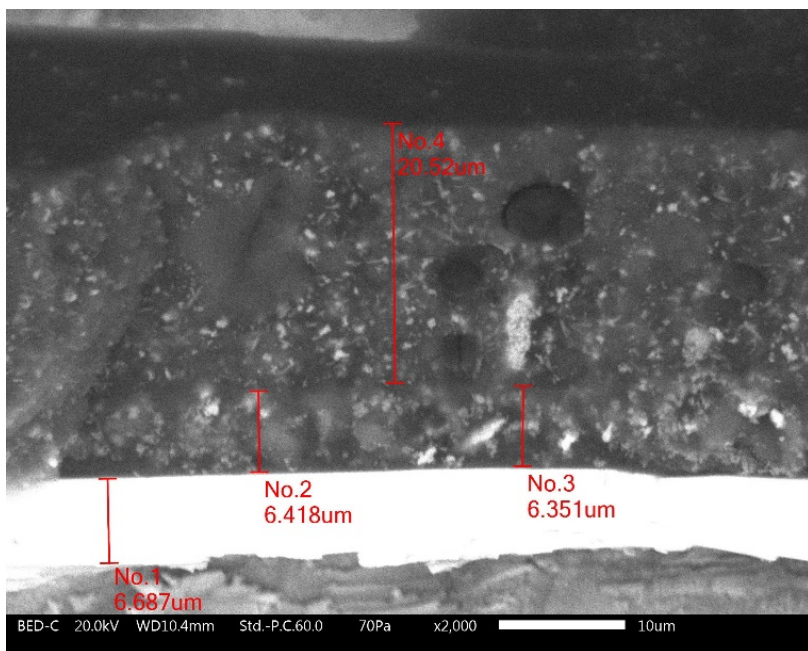
Figure 2. SEM cross-section image of sample Brown. From the bottom: the white layer represents the zinc layer, above which there is the primer, about 6 μm thick, and finally the topcoat.